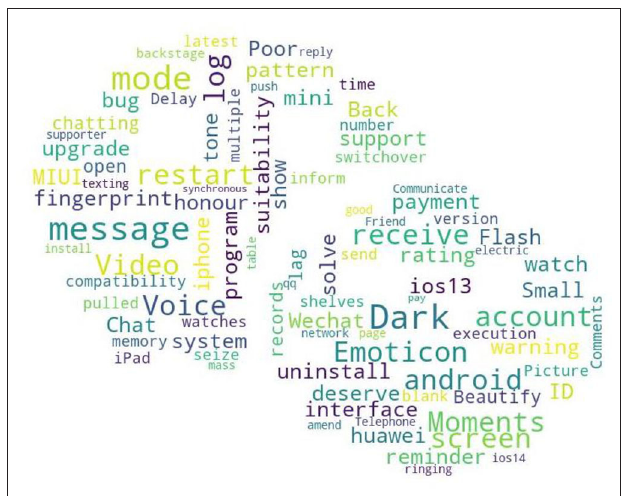
FIGURE 6 | Different requirements of WeChat on different operating system.